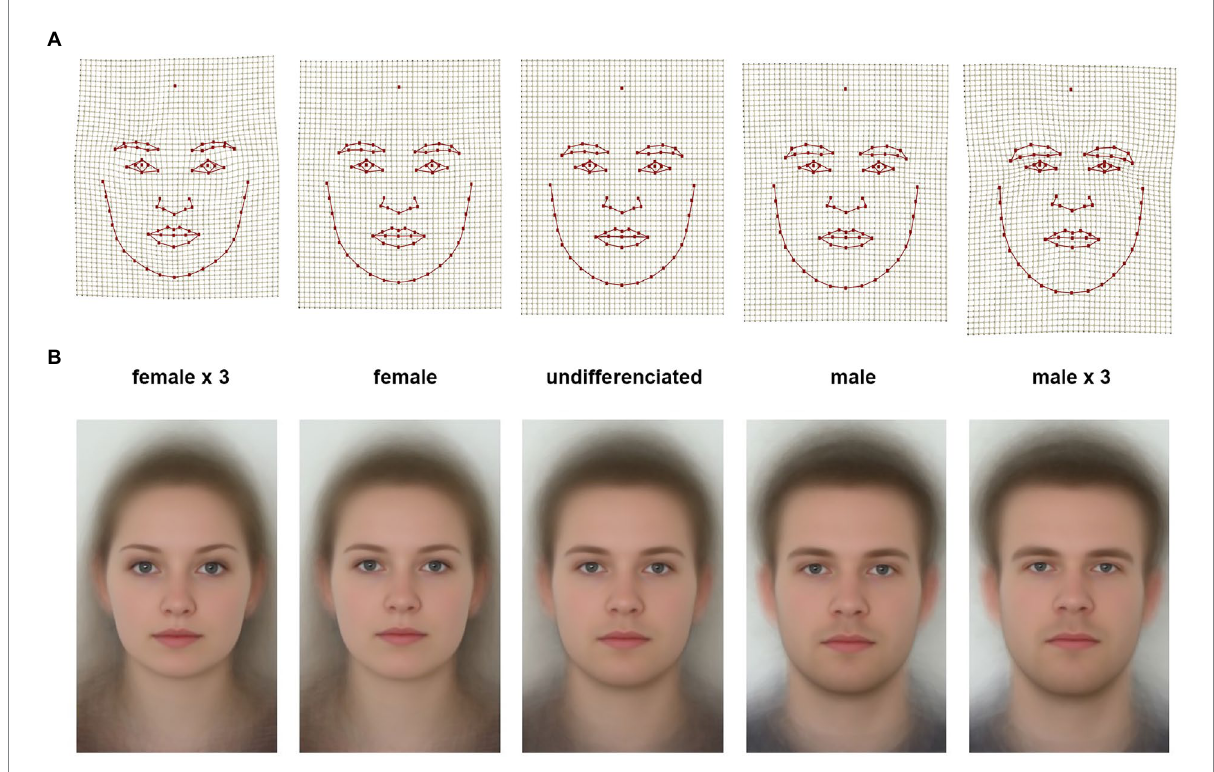
FIGURE 6 Sex differences in facial shape. (A) Deformation grids, and (B) geometric morphometric morphs display facial change from sexually undifferentiated shape (in the center) toward the average female face (left) and average male face (right). Two outer configurations display these changes exaggerated by a factor of 3. Sex differences are statistically significant ( N = 145, var. expl. 7%, p <